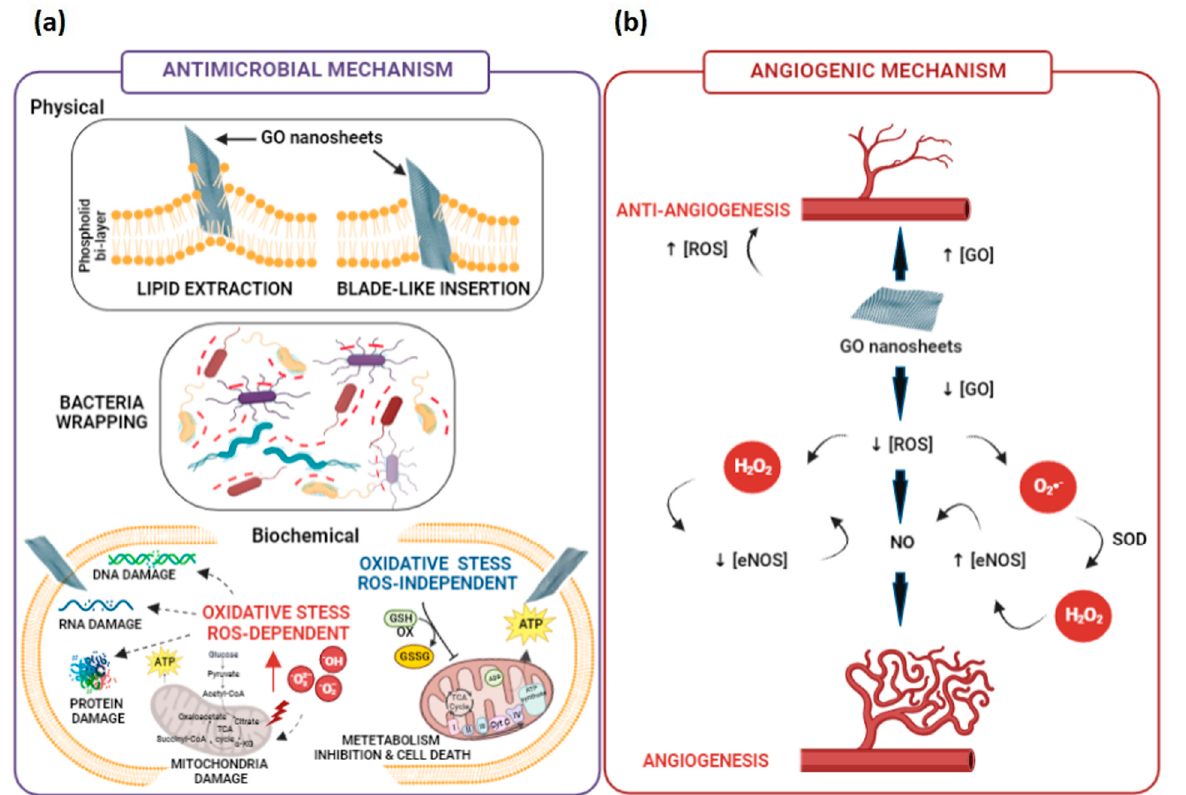
Figure 5. ( a ) Antimicrobial physical and biochemical mechanisms and ( b ) pro- and anti-angiogenic pathways involving GO-derivatives. Created with BioRender.com.